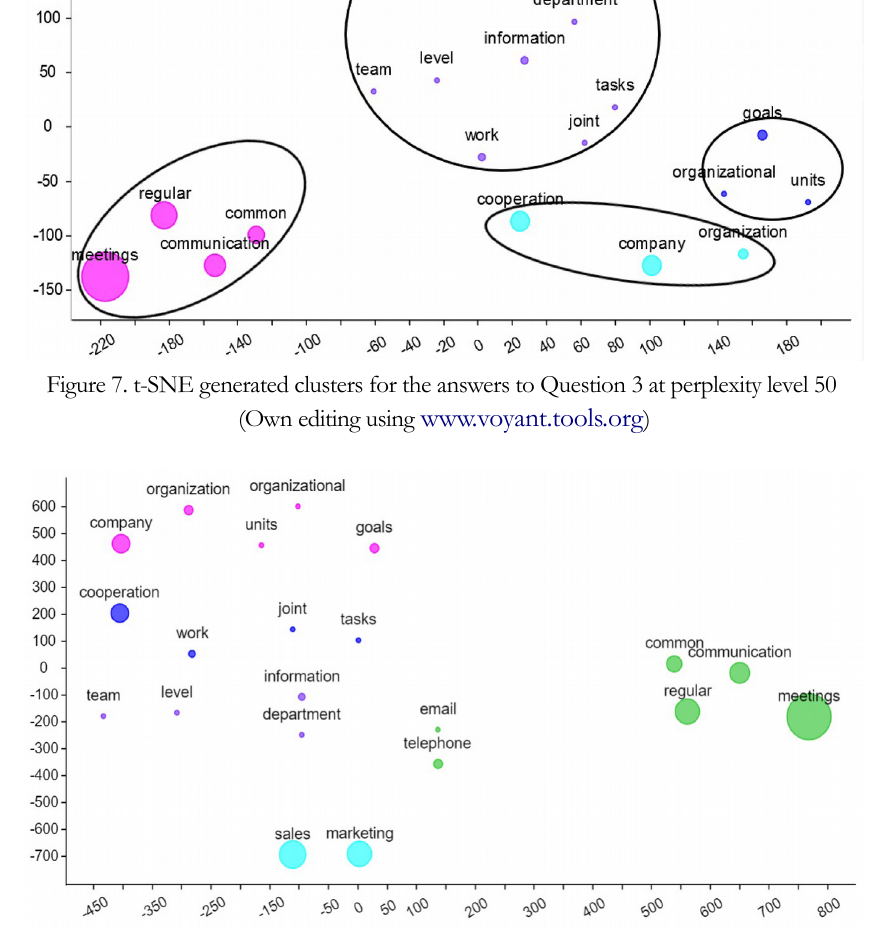
Figure 8. t-SNE generated clusters for the answers to Question 3 at perplexity level 100 (Own editing using www.voyant.tools.org )